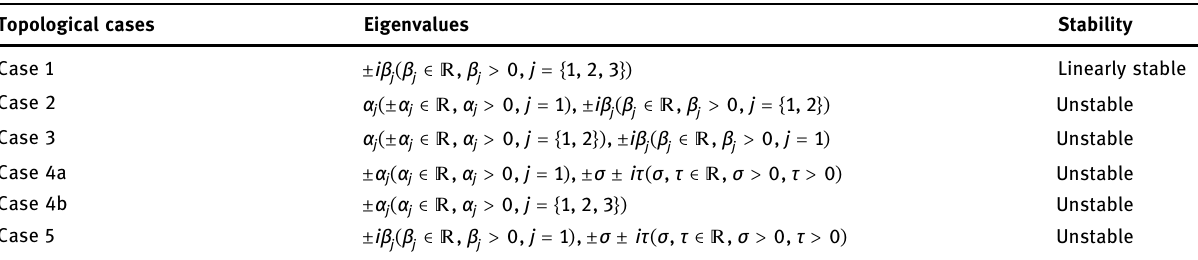
Table 3: Topological classi fi cation of equilibrium points in the gravitational potentials of asteroids Topological